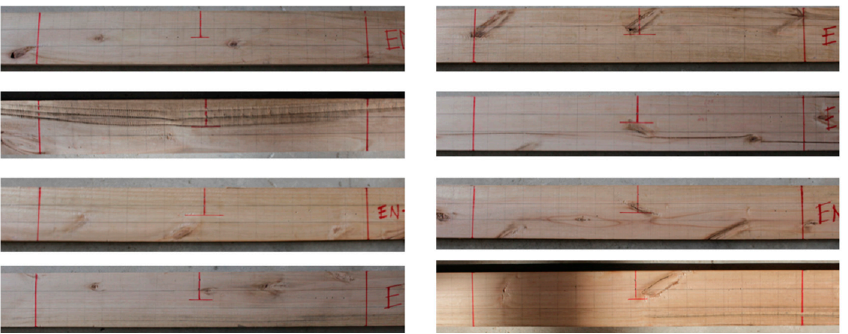
Figure 21. Defect visualization in the central third of the eight timber boards that met the current global serviceability criterion but not the proposed new local